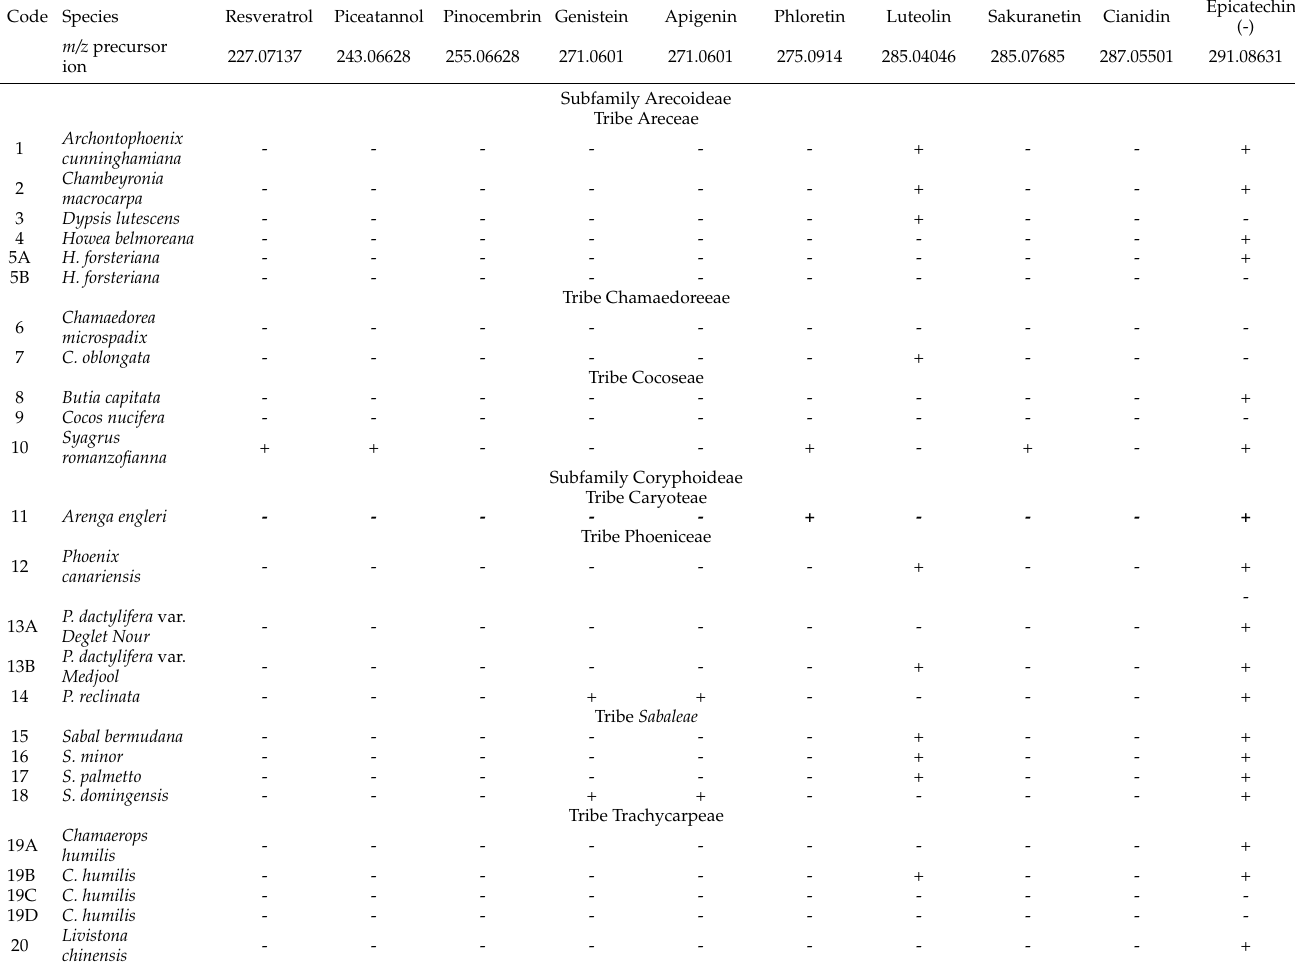
Table 3. Phenolic compounds detected by LC-MS in seeds of the analyzed Arecaceae